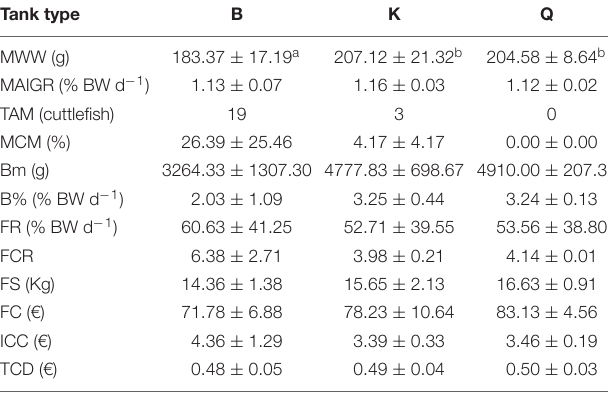
TABLE 1 | Mean water temperature, salinity and dissolved oxygen registered during the growth and reproduction stages of cuttlefish life cycle. Life Stage/Tank